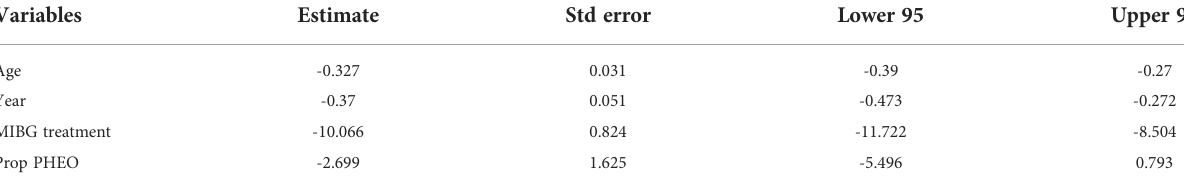
TABLE 4 Regression model comparing PFS between [ 131 I]MIBG and [ 177 Lu]Lu-DOTA-TATE treatments.